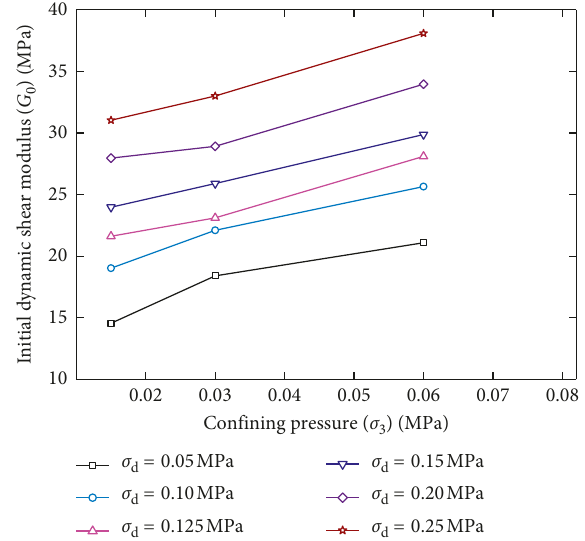
Figure 13: Initial dynamic shear modulus under different con- fining